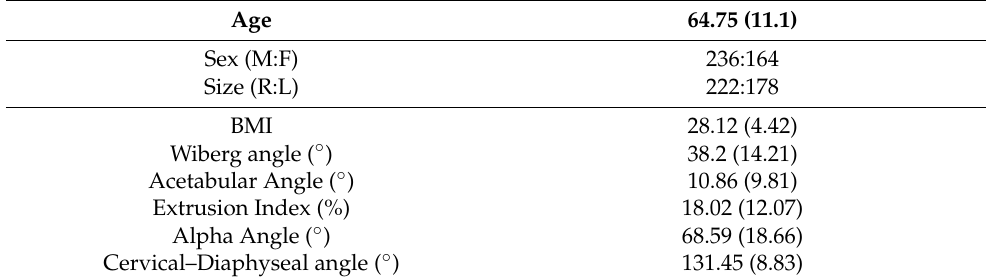
Table 1. Demographic data ( n = 400). Data are presented as mean (SD).